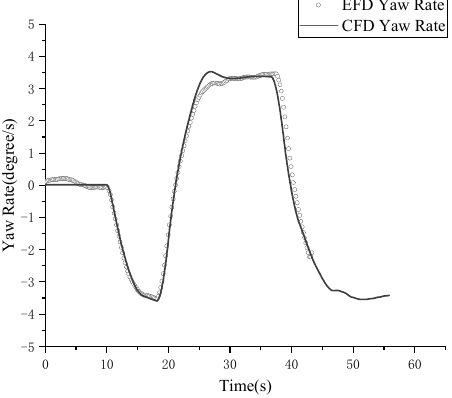
Figure 29. Yaw rate in 20° zigzag maneuver.